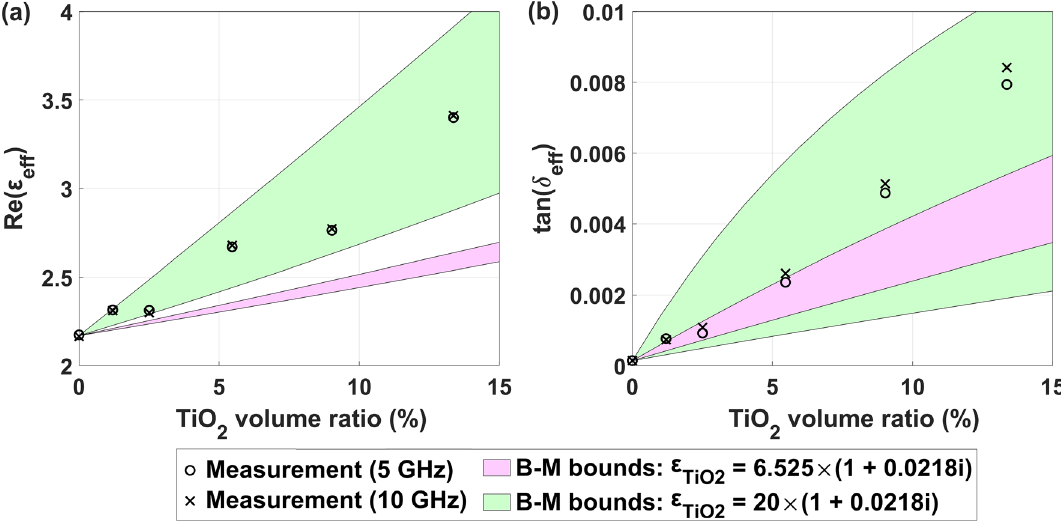
Figure 4. Correlation of the concentration of TiO 2 nanocrystals on the composite ( a ) real dielectric constant and ( b ) loss tangent at frequencies of 5 GHz and 10 GHz. For comparison, theoretical Bergman-Milton bounds are presented for two complex permittivities of TiO 2